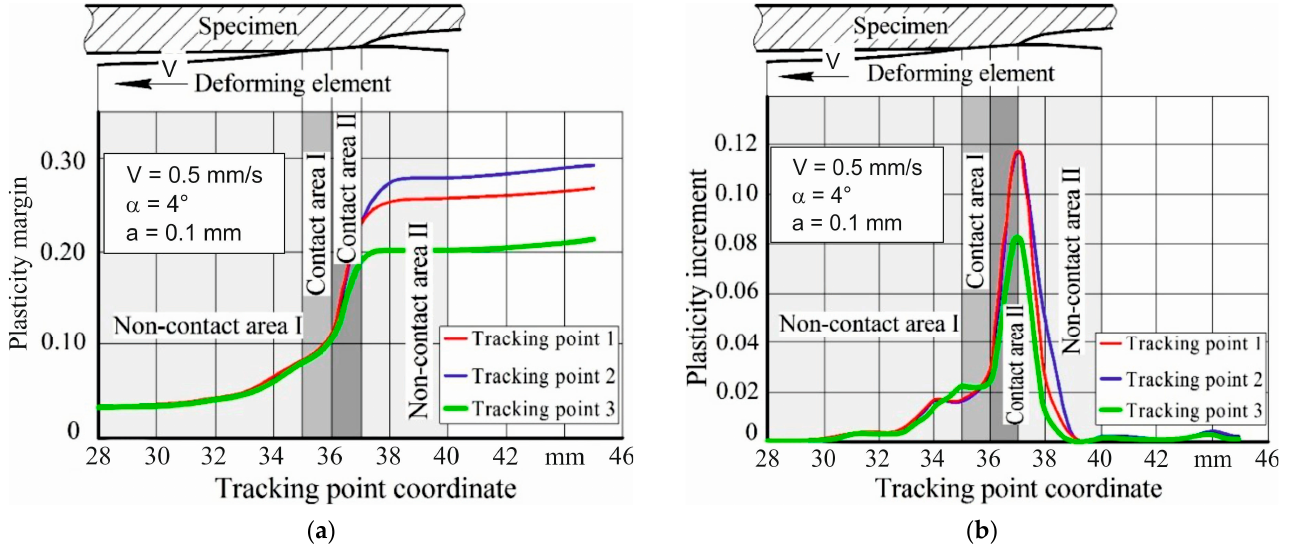
Figure 12. Dependence of plasticity margin ψ and plasticity increment Δψ on the tracking point coordinate. ( a ) plasticity margin, ( b ) plasticity increment. coordinate. ( a ) plasticity margin, ( b ) plasticity